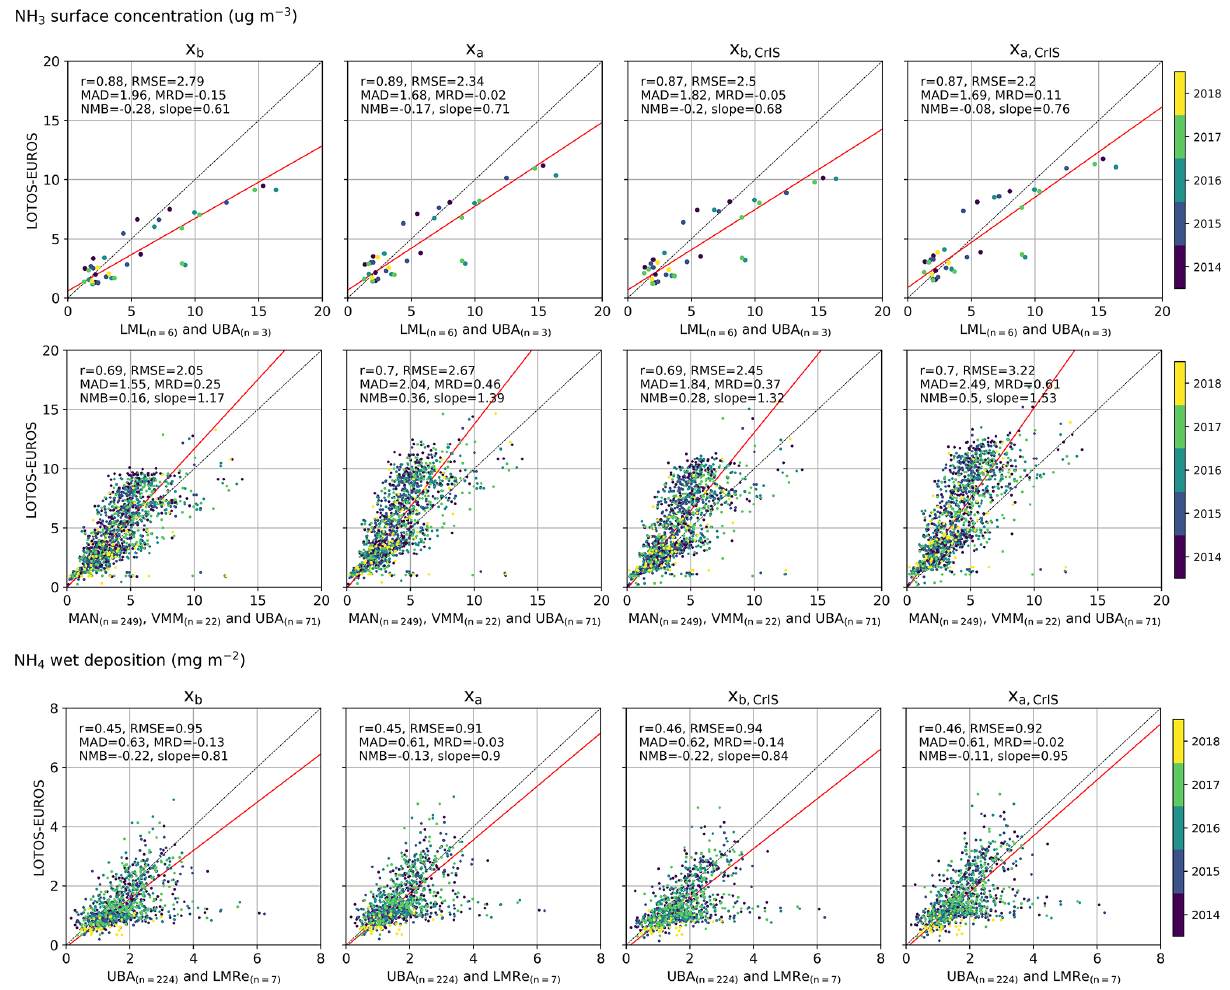
+ wet deposition fields to in situ 4